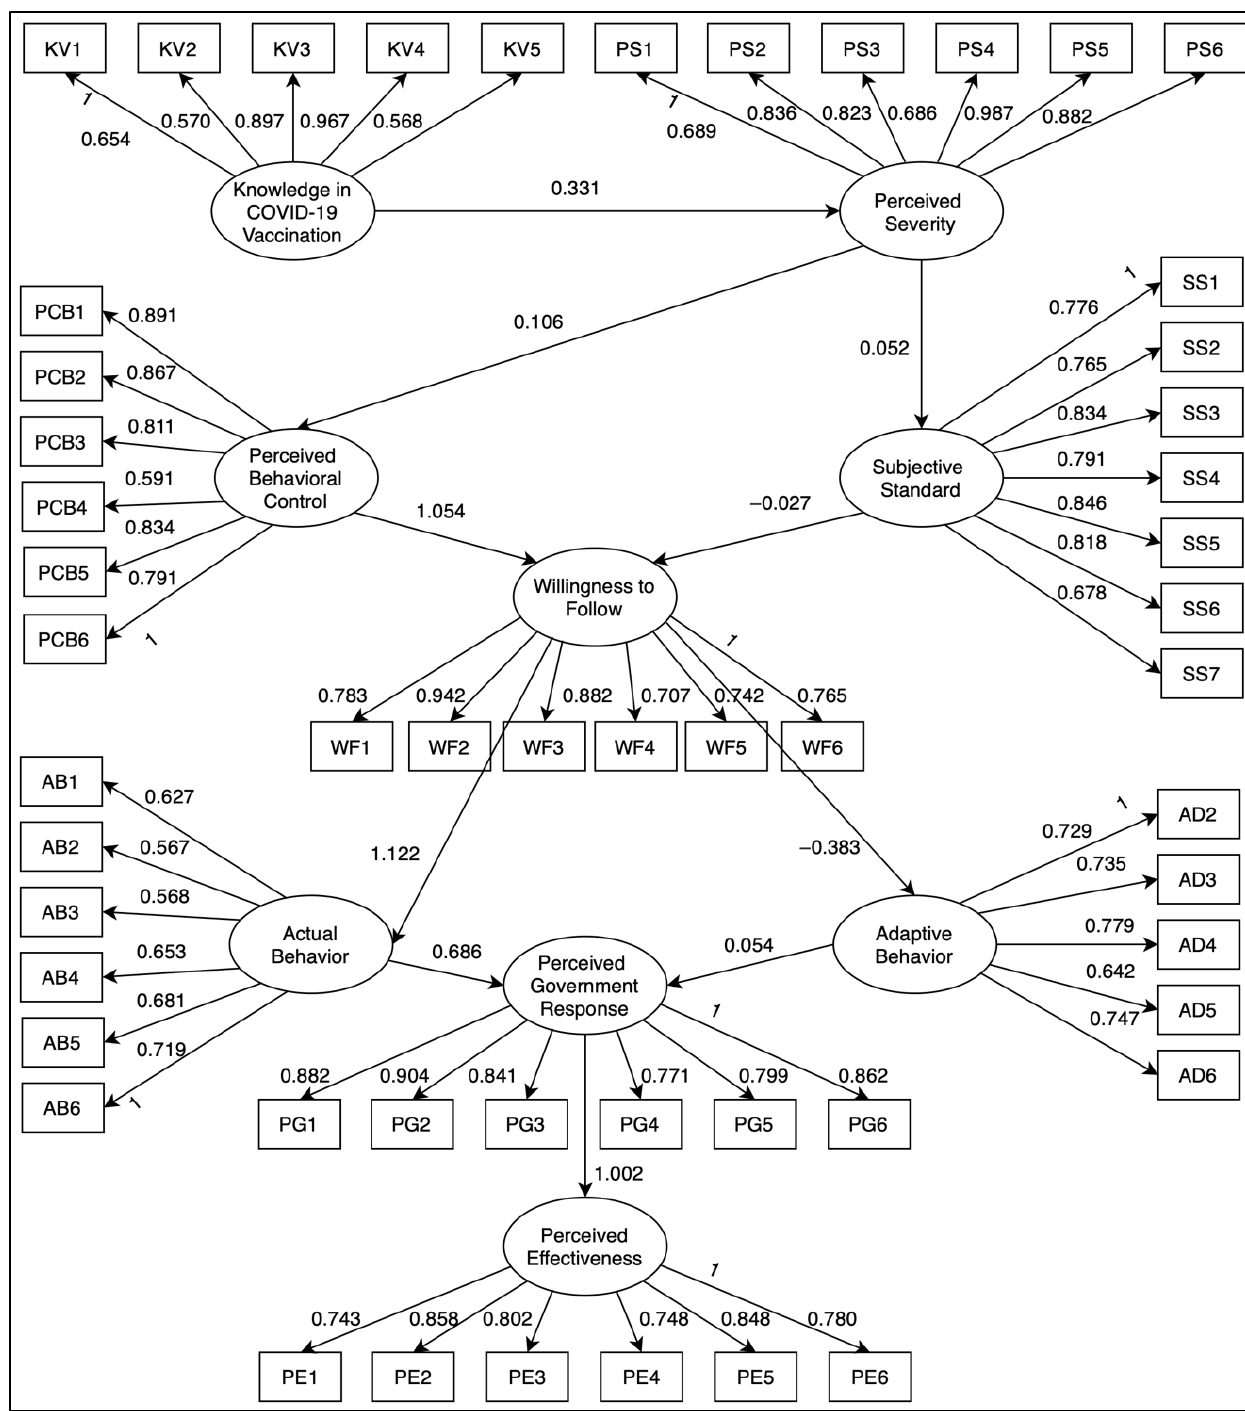
Figure 2. The final SEM for evaluating the perceived effectiveness of government response towards COVID-19 vaccination in Occidental Mindoro.